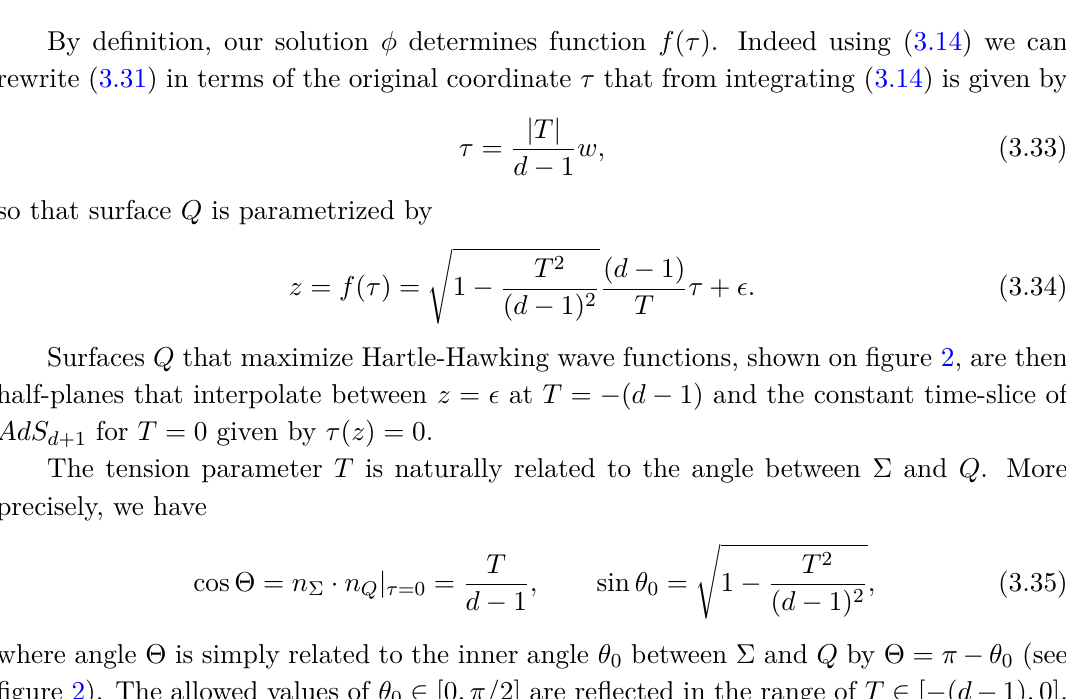
Figure 2 . Solutions (3.34) are half planes interpolating between the boundary at T = − ( d − 1) /l and the τ = 0 slice for T = 0 (in the text we used l = 1 ). The inner angle θ 0 is related to Θ and T via